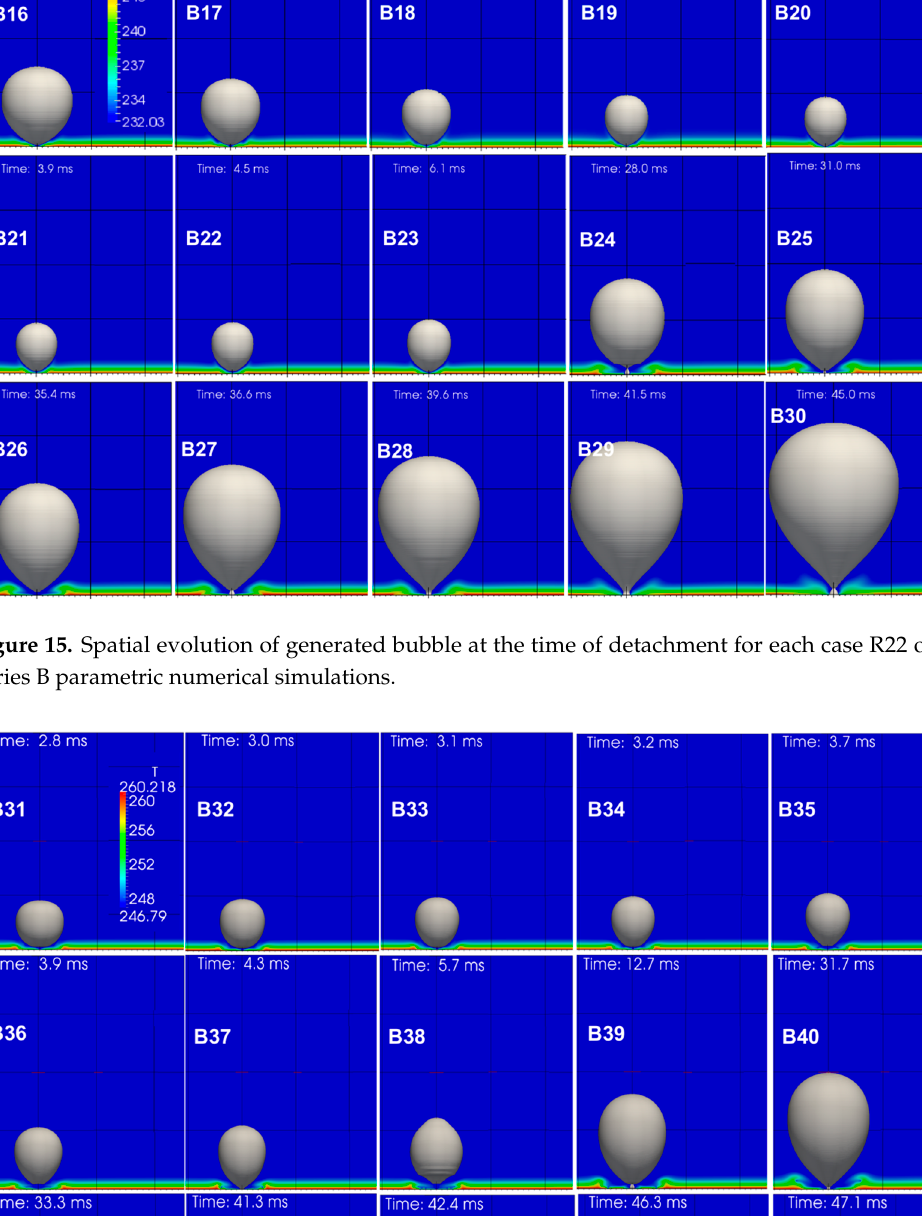
Figure 14. Spatial evolution of generated bubble at the time of detachment for each R113 case of the Series B parametric numerical simulations.